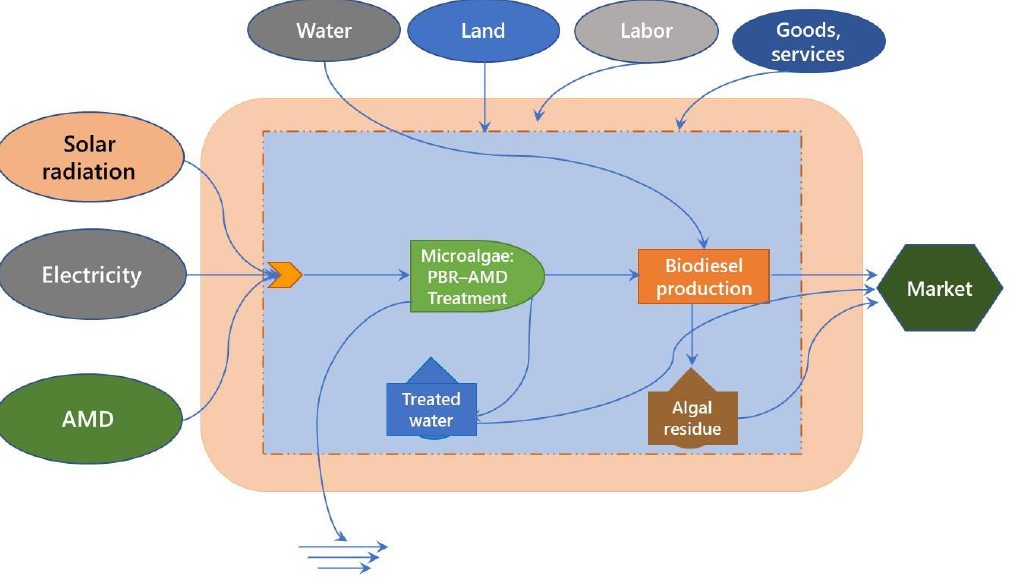
Figure 1. Emergy analysis in AMD treatment system involving immobilized acid-adapted microalgal strains, Desmodesmus sp. MAS1 and Heterochlorella sp. MAS3. Table 1. Emergy calculations for microalgae-based AMD treatment and biodiesel production.